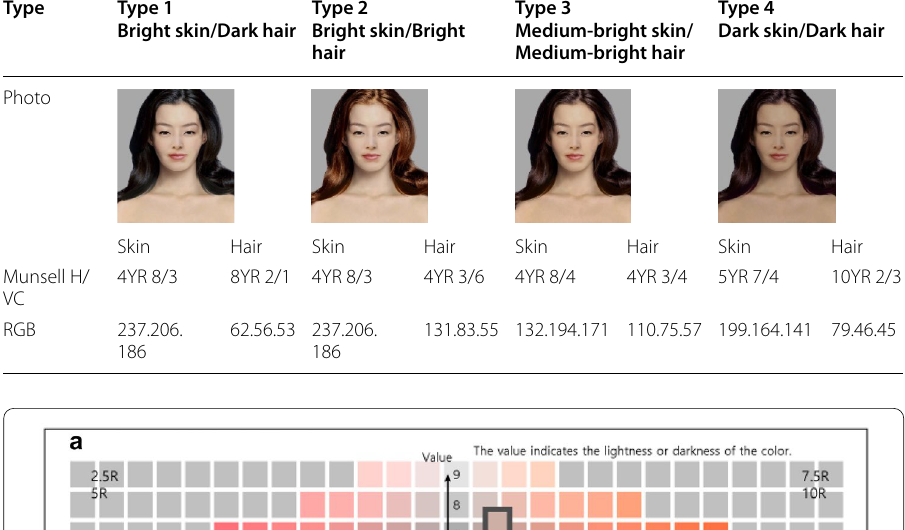
Table 1 Photographs for types of skin and hair color Type